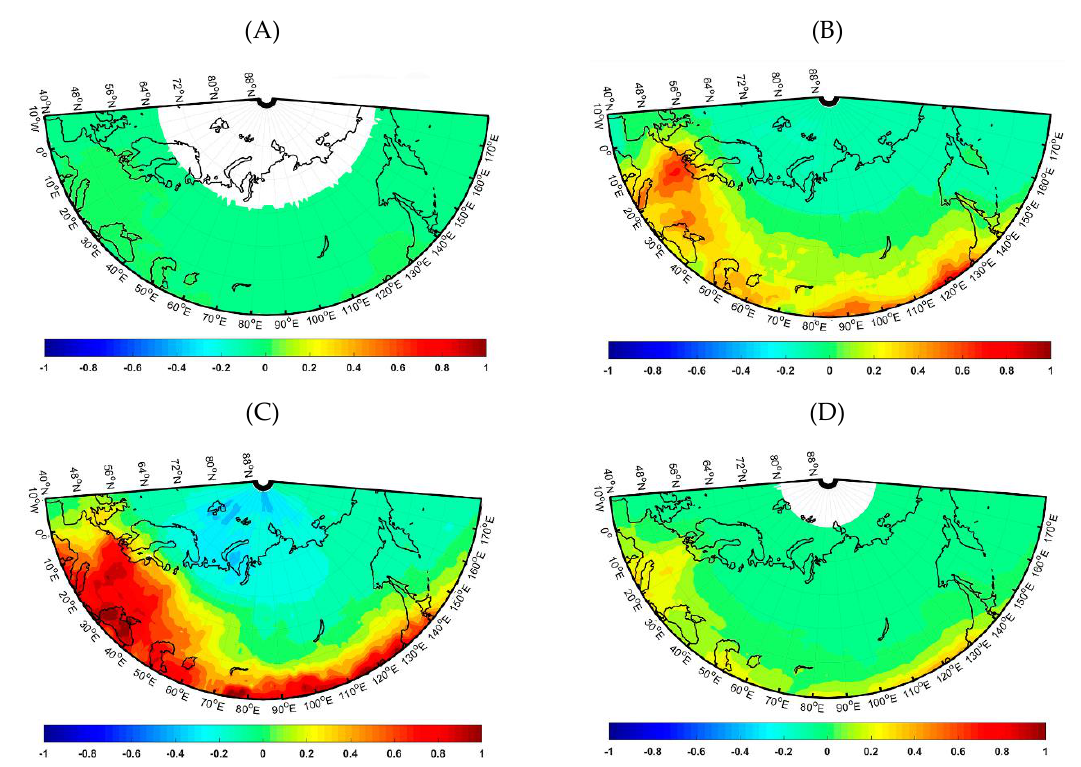
Figure 2. Absolute difference between the UV indices in 2005 with the application of the updated Macv2 CF factor minus UV indices with the standard OMI CF factor correction [68] for central months of the seasons: January ( A ), April ( B ), July ( C ), October ( D ). UV index is a widely used unitless quantity, defined by multiplying erythemal irradiance by 40 [1].